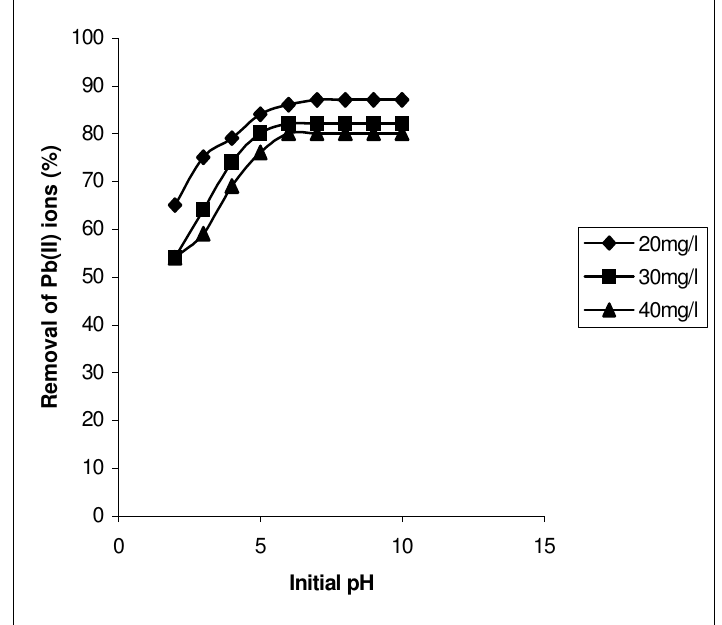
Figure 5 . Effect of initial p H on the removal of Pb(II) ions from aqueous solution by SCH